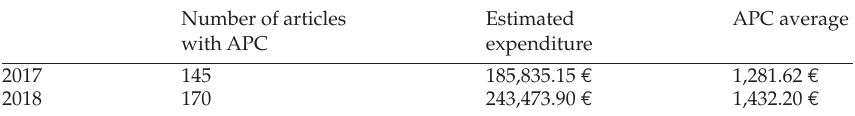
Table 8: Estimated expenditure on APC from the UPC for 145 articles in 2017 and 170 articles in